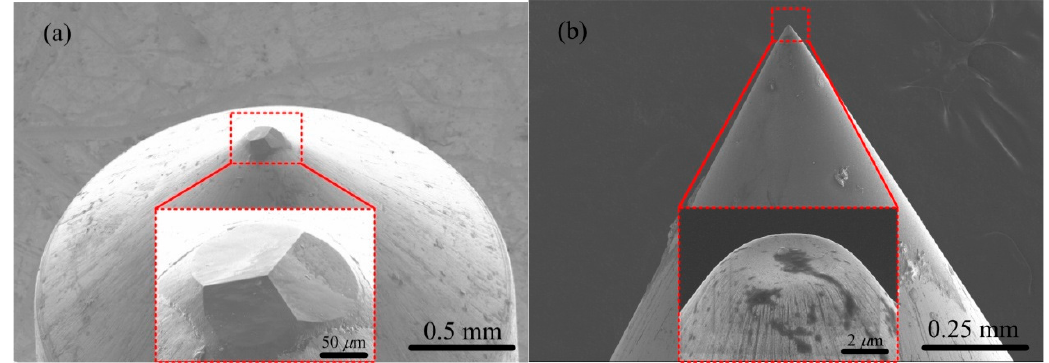
Figure 1. Scanning electron microscopy (SEM) images of ( a ) Berkovich, and ( b ) flat-tip indenters by HITACHI S-4800 (Tokyo, Japan). The insets in ( a , b ) show the enlarged images of the indenter tips, respectively. The pyramid lengths of Berkovich indenter in ( a ), with a facet angle of 65.3 degrees, are 62, 66, 75 μ m, respectively. The radius of flat-tip indenter in ( b ) is 2.5 μ m with a cone angle of 60 degrees.